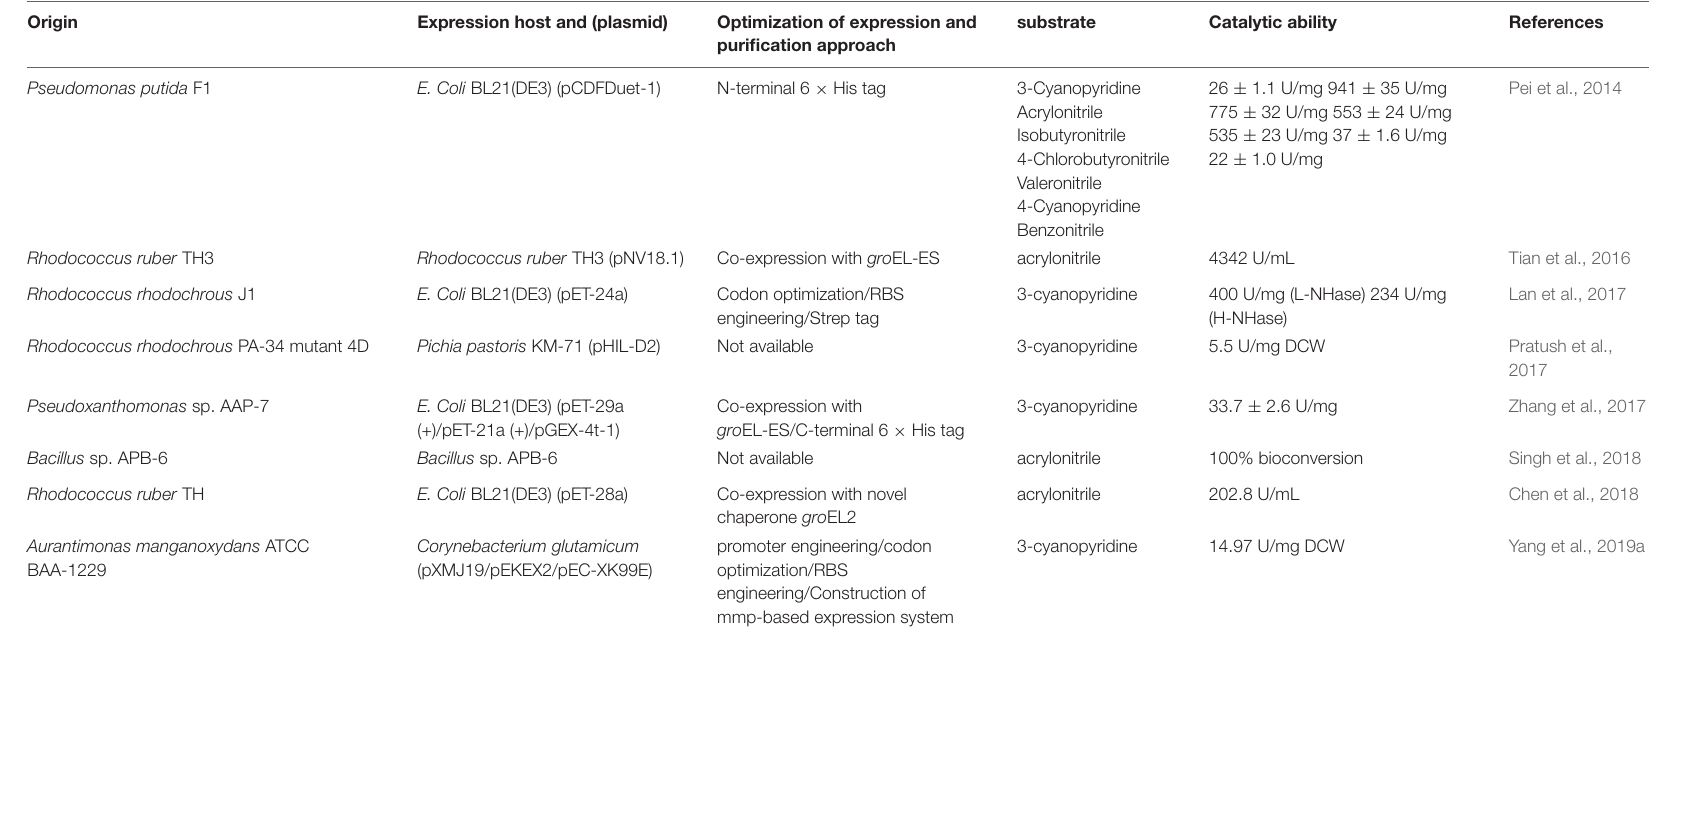
TABLE 1 | Summary of the advances in expression and purification of NHase in recent 5